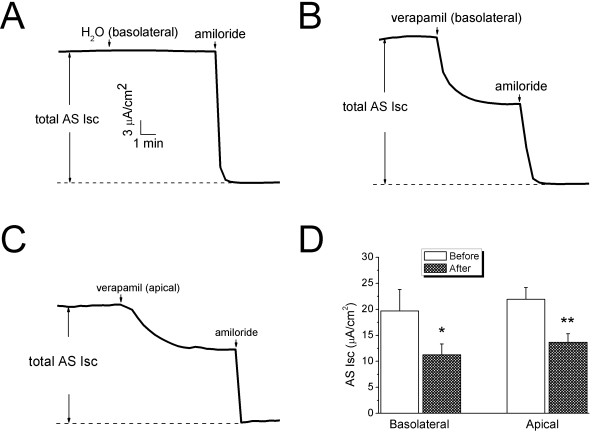
Comparison of verapamil-inhibitable Isc levels in H441 monolayers when applied to the apical or basolateral compartments. (A-C) Representative Isc traces showing the effects of water (H2O), verapamil applied to basolateral (B) and apical (C) compartments. The total AS Isc levels associated with ENaC are designated by pairs of vertical arrows. (D) AS Isc levels before and after verapamil delivery to the basolateral side or apical compartment. Paired t-test for comparison of current levels before and after verapamil. *P < 0.05 and **P < 0.01. n = 4-17.